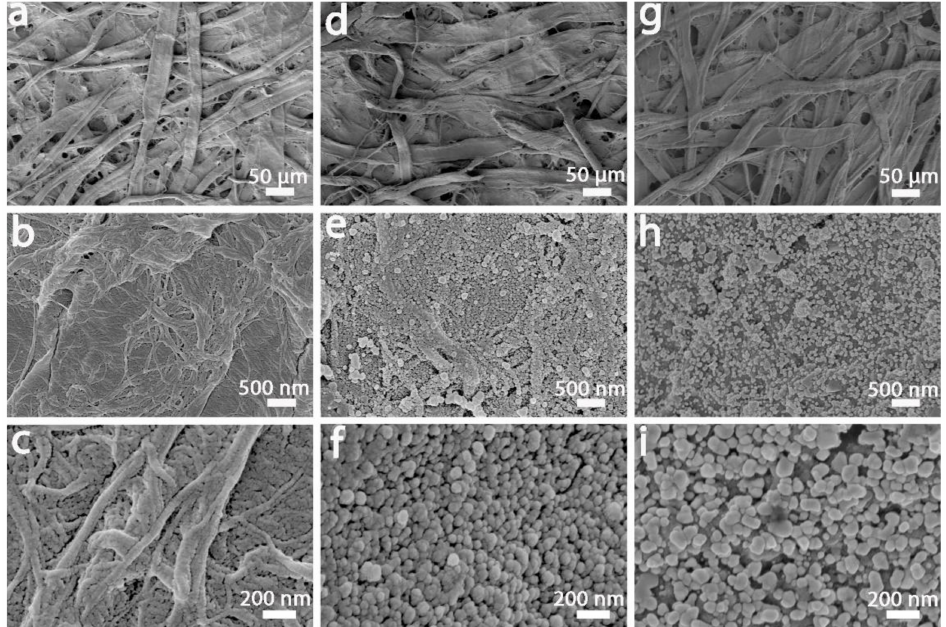
Figure 2. Representative SEM images of pure CFP ( a – c ), CFP@PDA ( d – f ) and CFP@PDA@AuNPs ( g – i ).